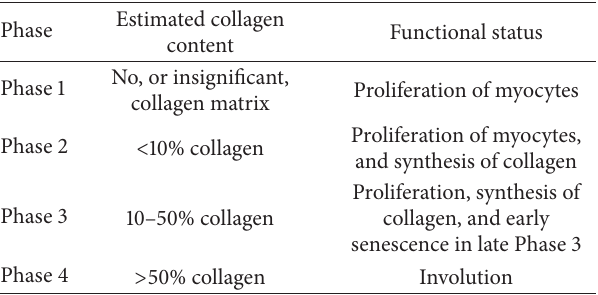
Table 1: Fibroid